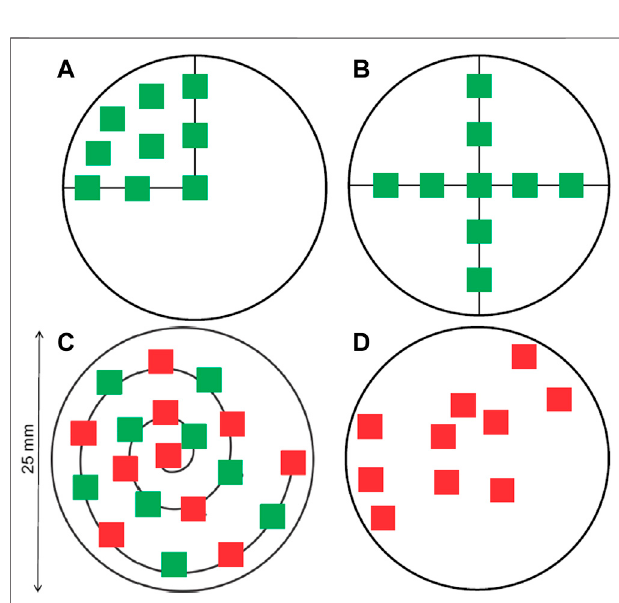
FIGURE 2 | Distribution of measure areas on a circular fi lter, following different layouts. (A) Spreading on a quarter of the fi lter. (B) Forming a cross. (C) Followingaspiral. (D) Randomplacement.Thegreensquarescorrespond to 7.3% of the fi lter area and the red boxes to 8.2%, respectively. Both togetherrepresent 15.5%ofthe fi lterarea(Huppertsbergand Knepper 2018).